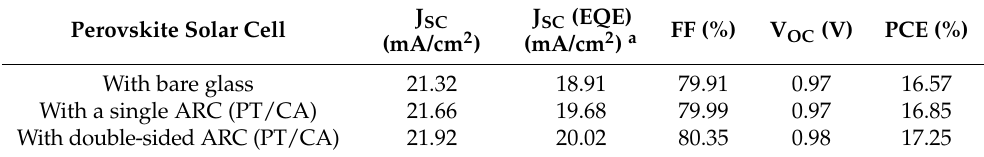
Table 1. Photovoltaic performance of perovskite solar cells before and after using the PT/CA antireflective films as the cover glass (perovskite composition: (CsPbI 3 ) 0.05 [(FAPbI 3 ) 0.9 (MAPbBr 3 ) 0.1 ] 0.95 ). J SC Perovskite Solar Cell (mA/cm 2